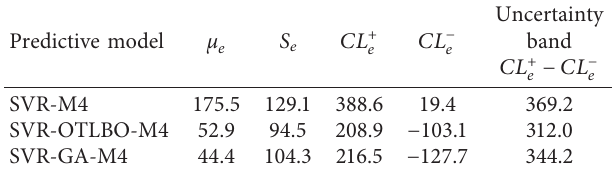
Table 5: Statistical characteristics of the prediction errors obtained by models proposed in the present